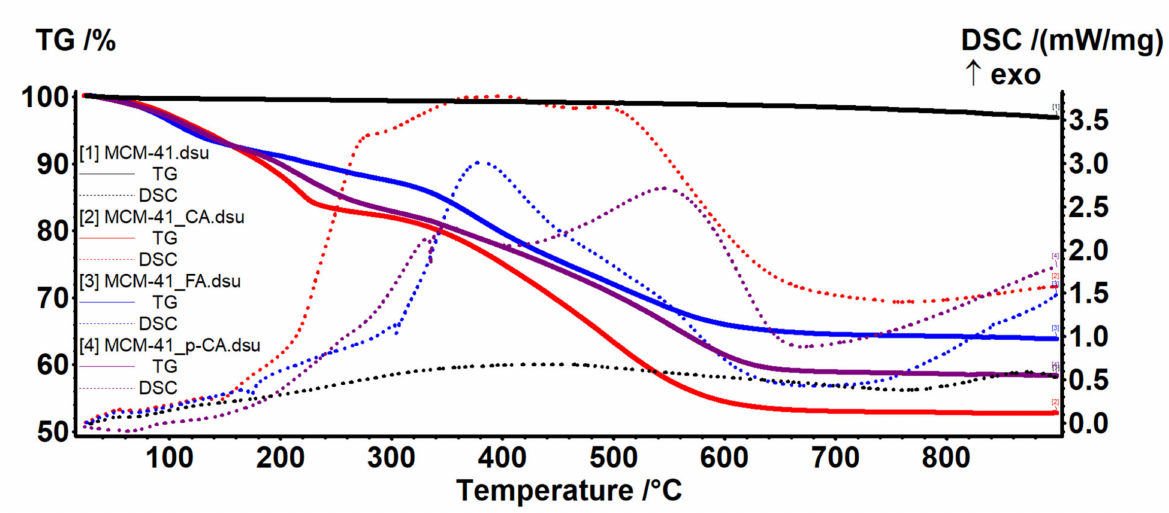
Figure 12. TG–DSC curves for MCM-41, pristine and loaded with polyphenols. The amount of adsorbed water and the quantity of silanol groups on the surface of MCM-41 sample was evaluated as indicated in [44]. The literature indicates two tem- perature intervals for elimination of adsorbed water molecules (RT–200 ◦ C) and for con- densation of silanol groups (200–900 ◦ C). Thus, between RT and 200 ◦ C the sample is